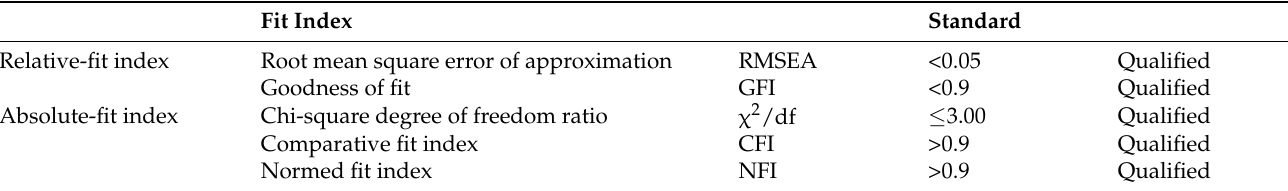
Table 4. The main indexes and standards